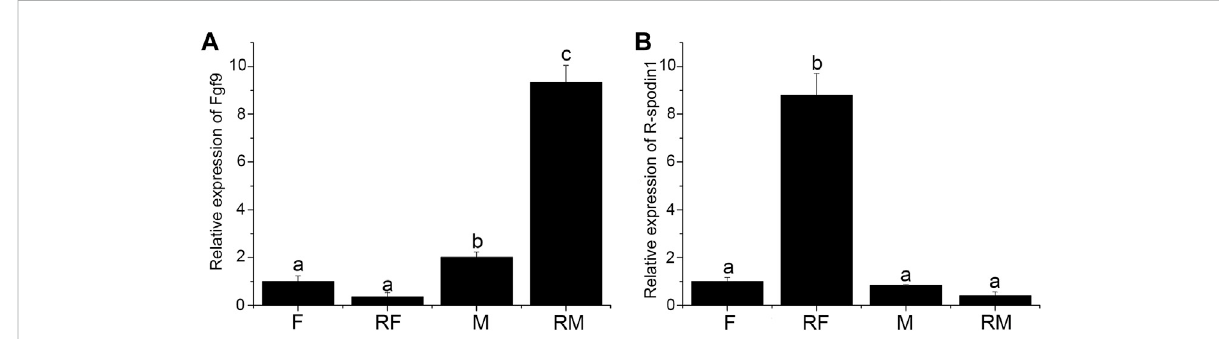
FIGURE 3 Expressionof fgf9 and rspo1 innormalgonadsandsex-reversalgonadsbyqRT-PCR. (A) Expressionanalysisof fgf9 mRNAinnormalgonadsand sex-reversal gonads by qRT-PCR; (B) expression analysis of rspo1 mRNA in normal gonads and sex-reversal gonads by qRT-PCR. The gonads were collected at 1 year old from three individuals and each reaction was repeated three times. Bars with different letters are signi fi cantly different ( p < 0.05).